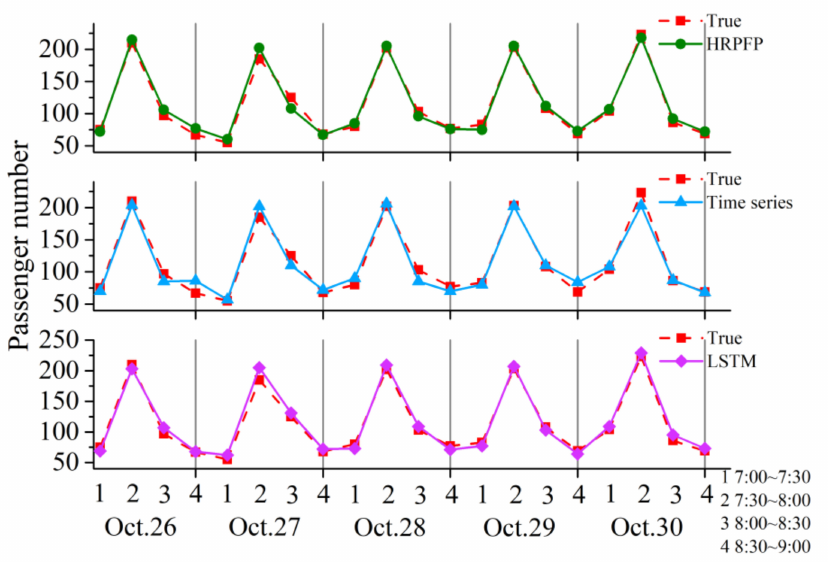
Figure 9. The comparison of three methods in passenger flow prediction using data from 7:00 to 9:00 for the 8th station in line 56008.